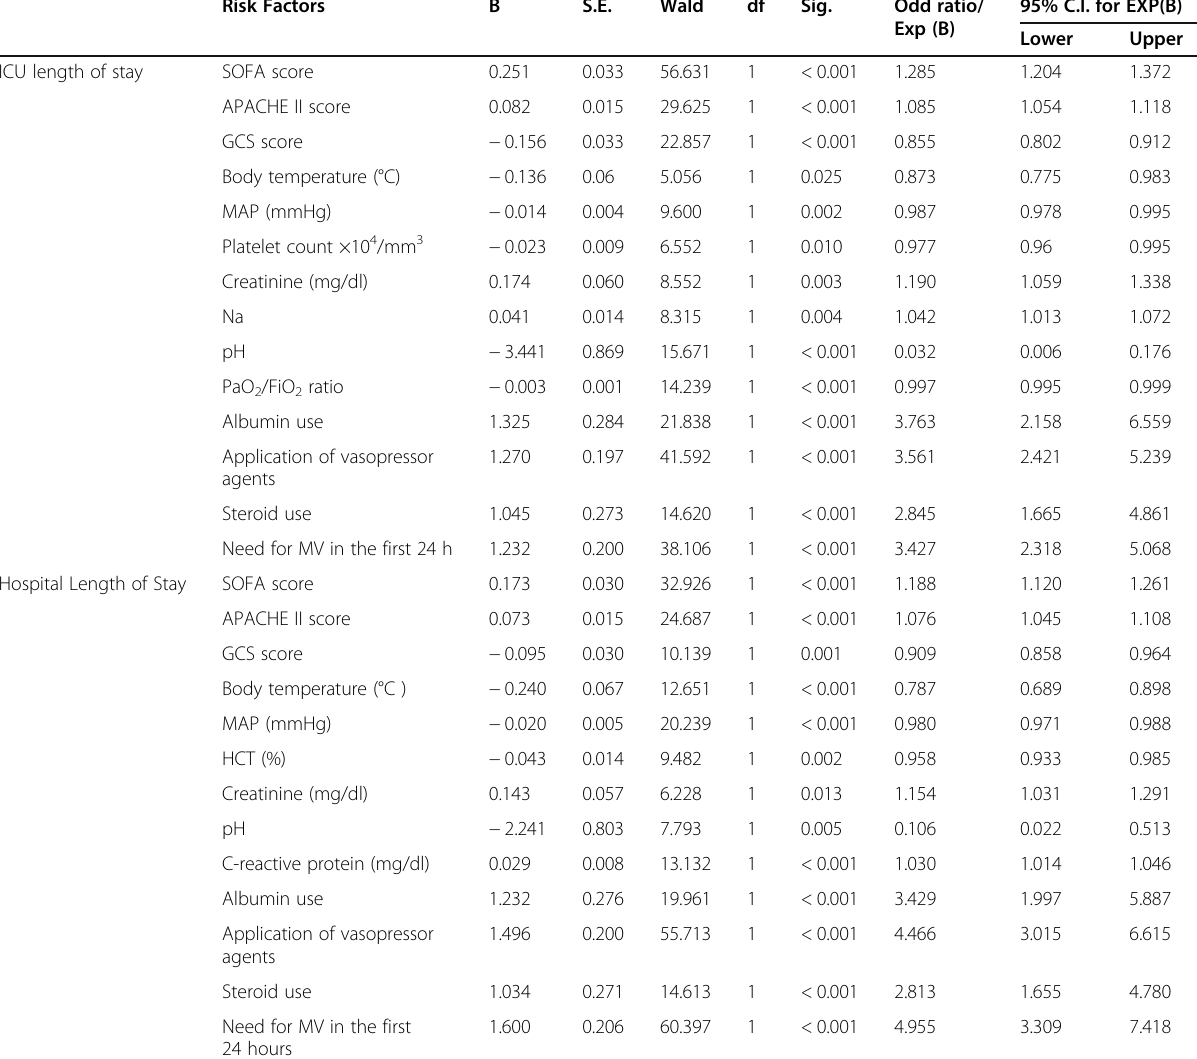
Table 2 Coefficient estimation of risk factors in univariate binary logistic regression model for prolonged